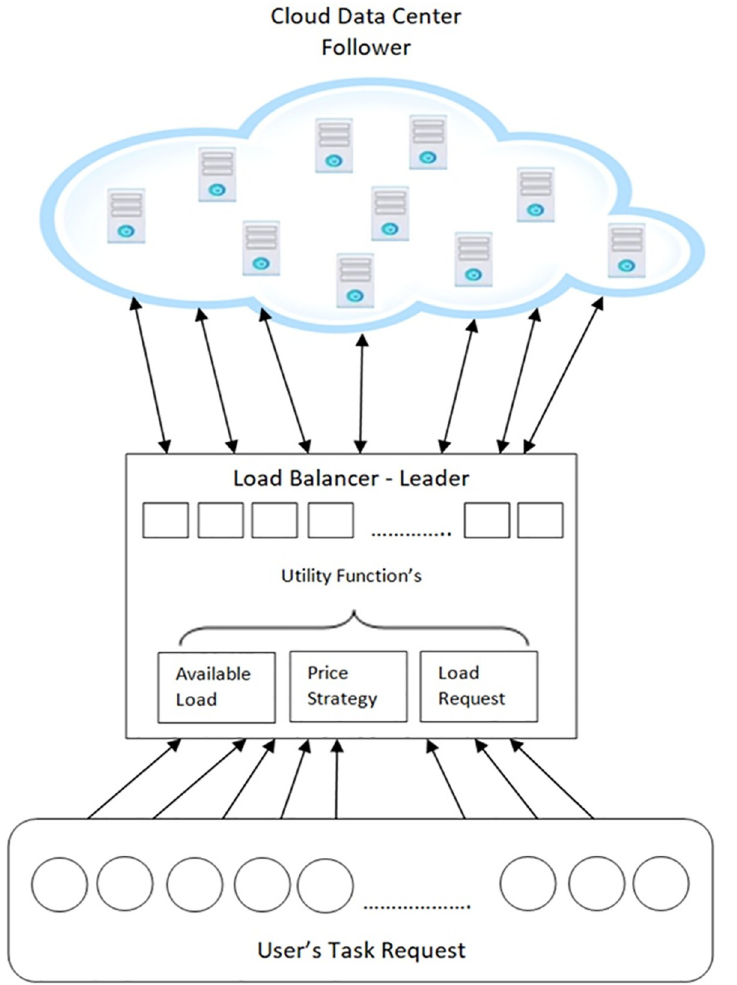
Fig 1. Stackelberg load balancer’s architecture